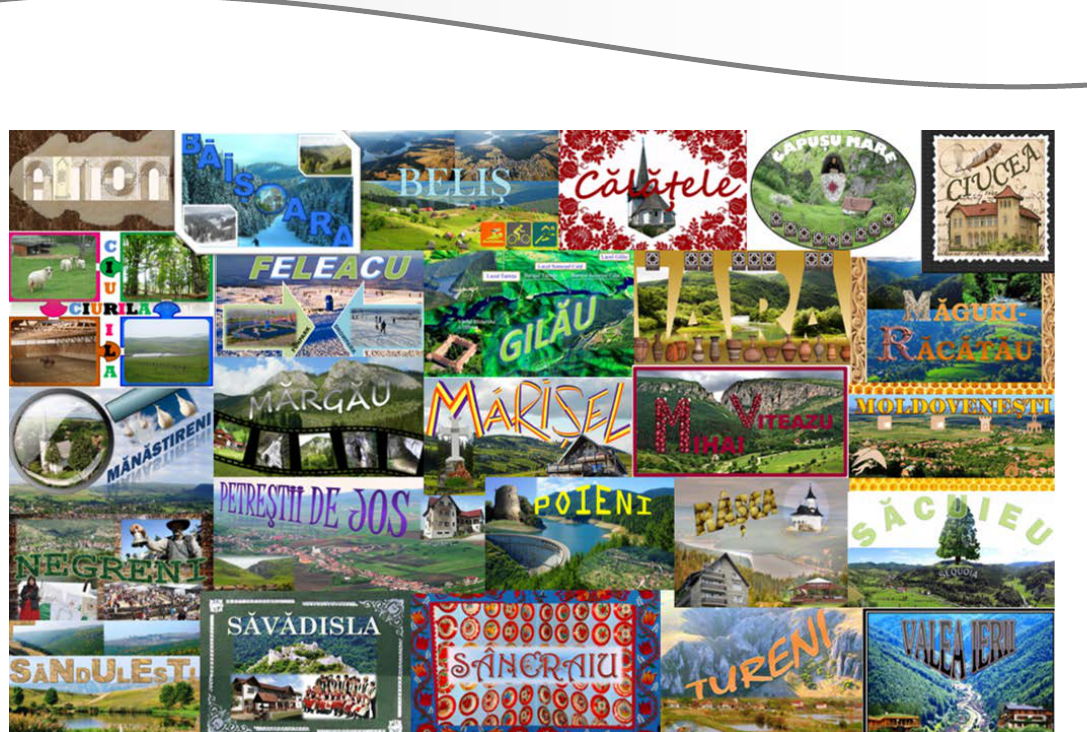
Figure 2: Collage of the brand image proposals Source: Răcăşan (2018), with